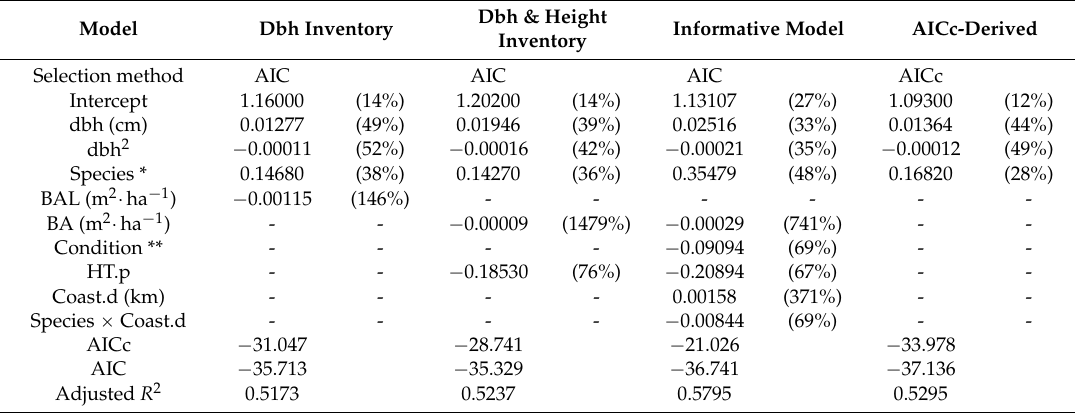
Figure 3. Influence of ecological gradient ‘distance from the coast’ on MaxB within the second log for living ( A ) and dead ( B ) redwood and Douglas-fir branches, and actual data for redwood (*) and Douglas-fir (o) in Mendocino County, California. Table 3. MaxB model coefficients (s.e. as percent of coefficient in parentheses) for Mendocino County,